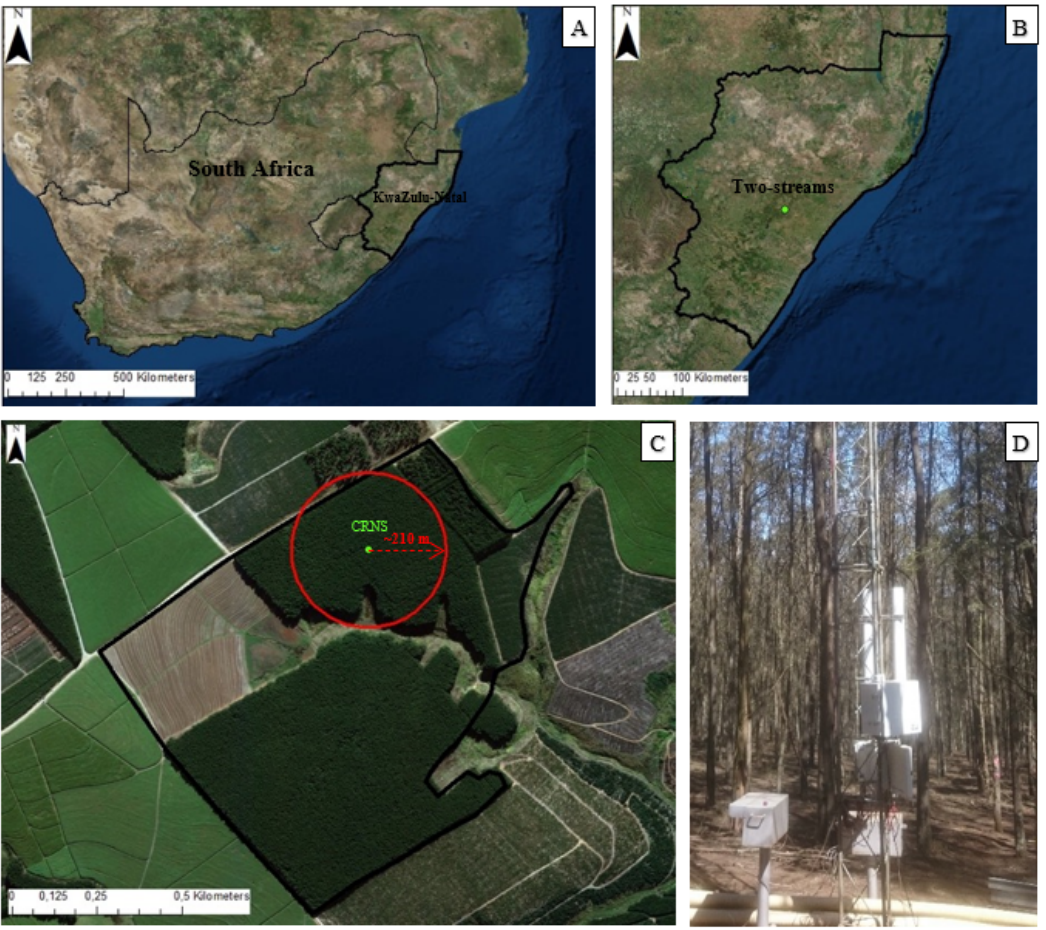
Figure 1. The location of the Two-Streams Research Catchment in KwaZulu-Natal, South Africa is shown in plates ( B ) and ( A ), respectively. The position of the CRNS’s and footprint in the Acacia mearnsii plantation are shown in ( C ). The lower CRNS mounted on the lattice mast is shown in ( D ).